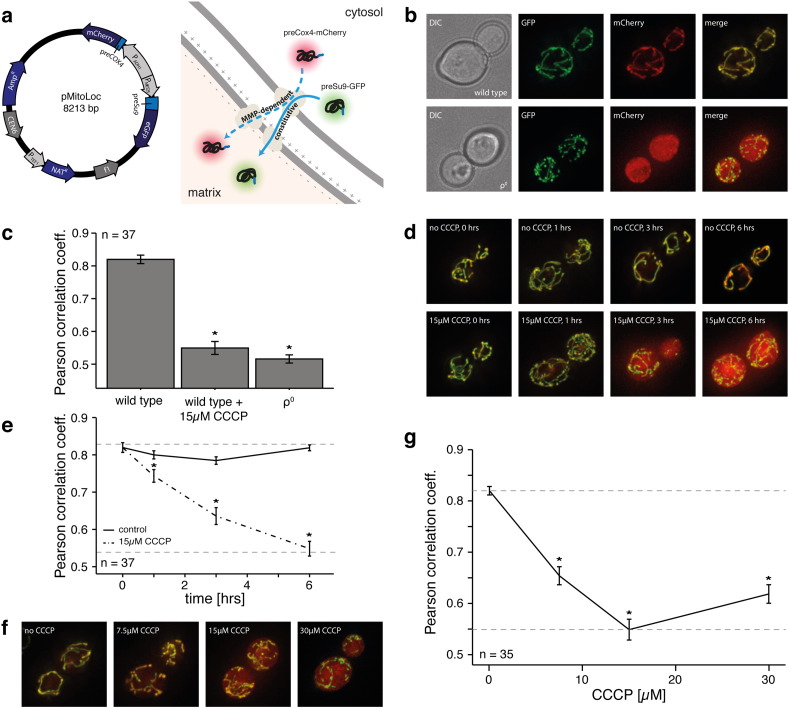
Quantification of the mitochondrial membrane potential by co-correlation analysis of differentially imported mitochondrial proteins.(a) (left) Plasmid map of pMitoLoc and (right) schematic outline of the MMP-dependent and -independent mitochondrial import of preCOX4-mCherry and preSU9-GFP.(b) Wide-field microscopy images of YSBN1 wild type and respiratory-deficient ρ0 yeast cells carrying pMitoLoc. Mitochondrial structures are detected by preSU9-GFP (green). In typical wild-type cells, localisation of preCOX4-mCherry (red) is equally almost completely mitochondrial, and the two markers co-localise. In respiratory-deficient ρ0 cells, mitochondrial import of preCOX4-mCherry (red) is no longer detected while preSU9-GFP (green) shows constitutive mitochondrial localisation; co-localisation is lost.(c) MMP based co-localisation of preSU9-GFP and preCOX4-mCherry (‘MitoLoc’), expressed as Pearson correlation coefficient (PCC). The PCC of 0.82 in exponentially growing wild-type cells is reduced to 0.55 in CCCP-treated and 0.52 in respiratory-deficient ρ0 cells. n = 37; * p < 0.01; error bars represent +/− SEM.(d) Wide-field microscopy images of YSBN1 wild-type cells treated with DMSO (upper panel) or 15 μM CCCP (lower panel) and imaged after the time indicated. While DMSO does not lead to a delocalisation of preCOX4-mCherry (red), CCCP treatment results in a loss of MMP and cytosolic localisation of preCOX4-mCherry; preSU9-GFP (green) remains mitochondrial.(e) Time-dependent loss of co-localisation upon treatment of yeast cells with the mitochondrial uncoupler CCCP. Wild-type YSBN1 cells were treated with 15 μM CCCP and imaged after the time indicated. Co-localisation analysis of MMP based on MitoLoc allows quantification of the gradual decline in MMP with time, eventually reaching complete delocalisation after 6 h. n = 37; * p < 0.01; error bars represent +/− SEM.(f) Wide-field microscopy images of YSBN1 wild-type cells treated with the CCCP concentration indicated and imaged after 6 h. De-localisation of preCOX4-mCherry (red) is visually evident at 15 μM CCCP, while preSU9-GFP (green) remains mitochondrial.(g) Quantification of CCCP-induced MMP loss based on co-localisation analysis of preSU9-GFP and preCOX4-mCherry by computational analysis. A pronounced loss of MMP is detectable already at 7.5 μM CCCP after 6 h of incubation. n = 35; error bars represent +/− SEM.